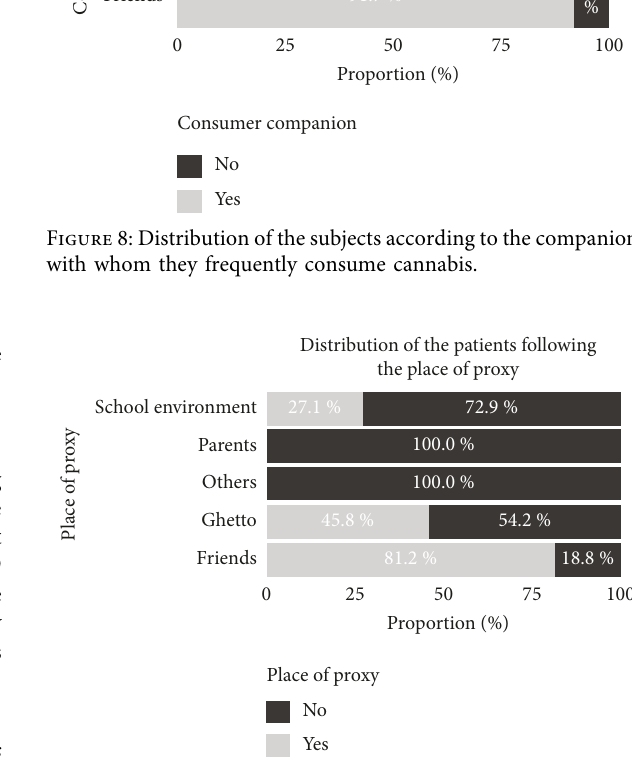
Figure 9: Distribution of the subjects according to the place of